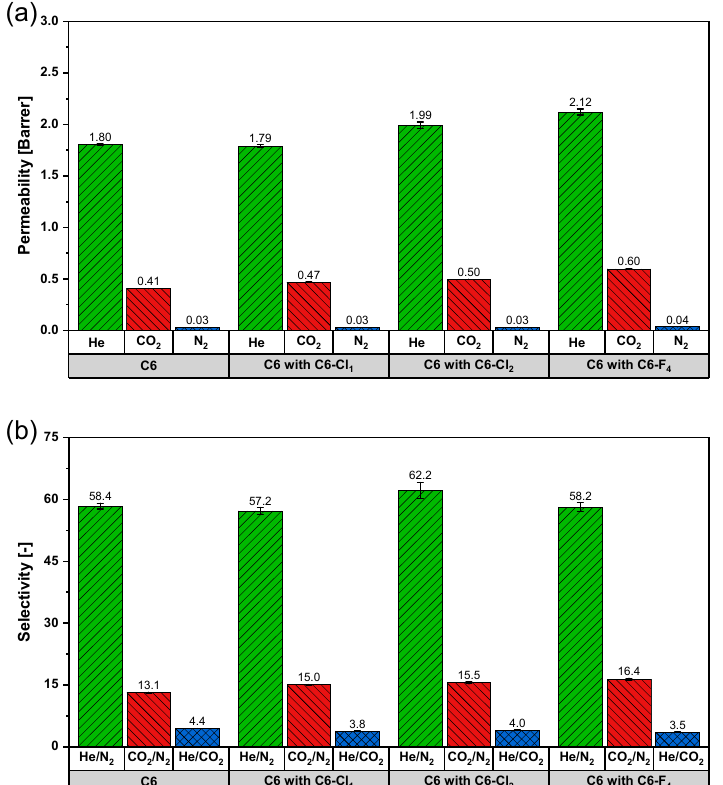
Figure 4. Gas permeation data and ideal gas selectivities of smectic LC membranes with various halogenated LCs. ( a ) Single gas permeability (He, CO 2 and N 2 ) of smectic C6 membranes with respectively 30 wt% C6-Cl 1 , 30 wt% C6-Cl 2 and 25 wt% C6-F 4 measured at 40 ◦ C and 6 bar feed pressure. ( b ) Ideal gas selectivities (He/N 2 , CO 2 /N 2 and He/CO 2 ) of smectic C6 membranes with respectively 30 wt% C6-Cl 1 , 30 wt% C6-Cl 2 and 25 wt% C6-F 4 at 40 ◦ C. The small error bars